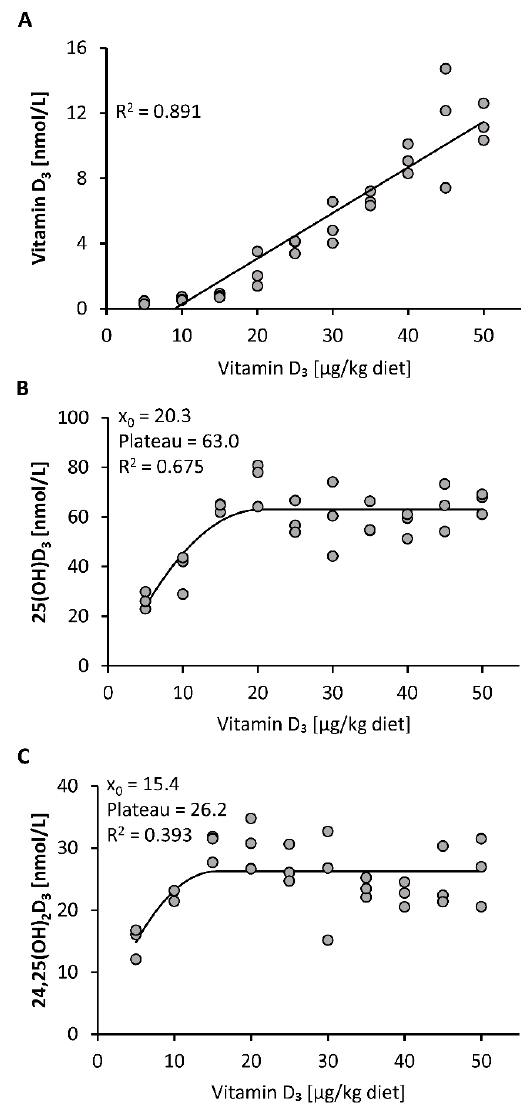
Figure 1. Plasma concentrations of vitamin D 3 ( A ), 25(OH)D 3 ( B ) and 24,25(OH) 2 D 3 ( C ) in mice that were fed 10 different doses of dietary vitamin D 3 for three weeks ( n = 3). The regression line is linear for vitamin D 3 ( A ) and curvilinear-plateau for 25(OH)D 3 ( B ) and 24,25(OH) 2 D 3 ( C ). 25(OH)D 3 , 25-hydroxyvitamin D 3 ; 24,25(OH) 2 D 3 , 24,25-dihydroxyvitamin D 3 ; R 2 , squared correlation; x 0 , the x value at which the curve merges into the plateau.